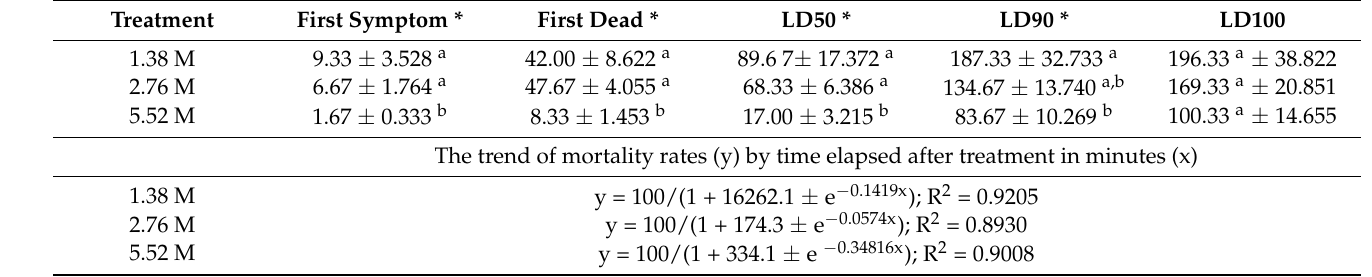
Table 1. Mean ± SE (standard error) of time (in minutes) elapsed after treatment till the occurrence of events.